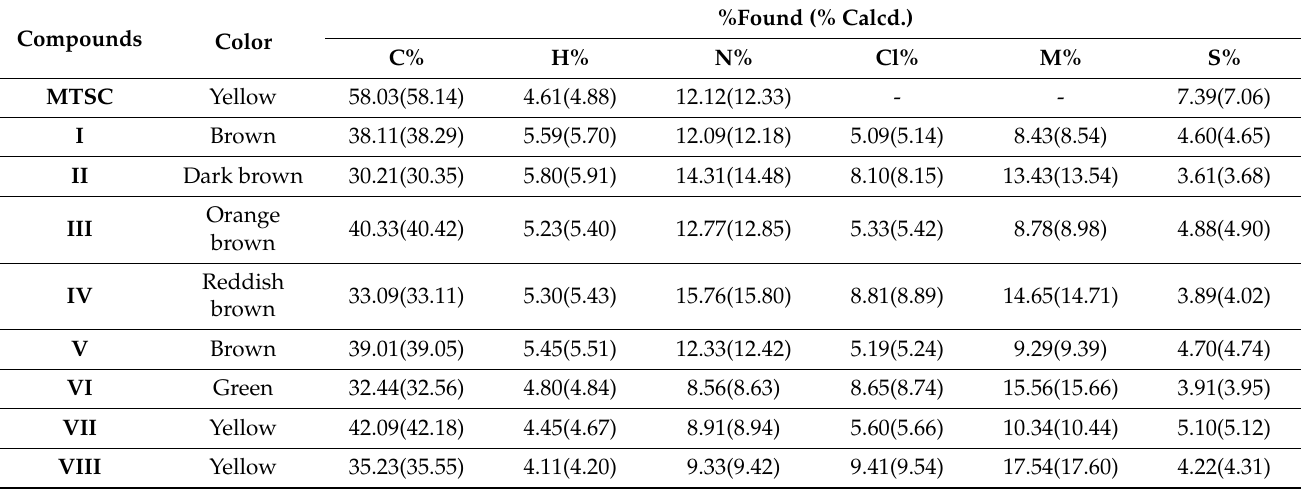
Table 1. Data of MTSC and its